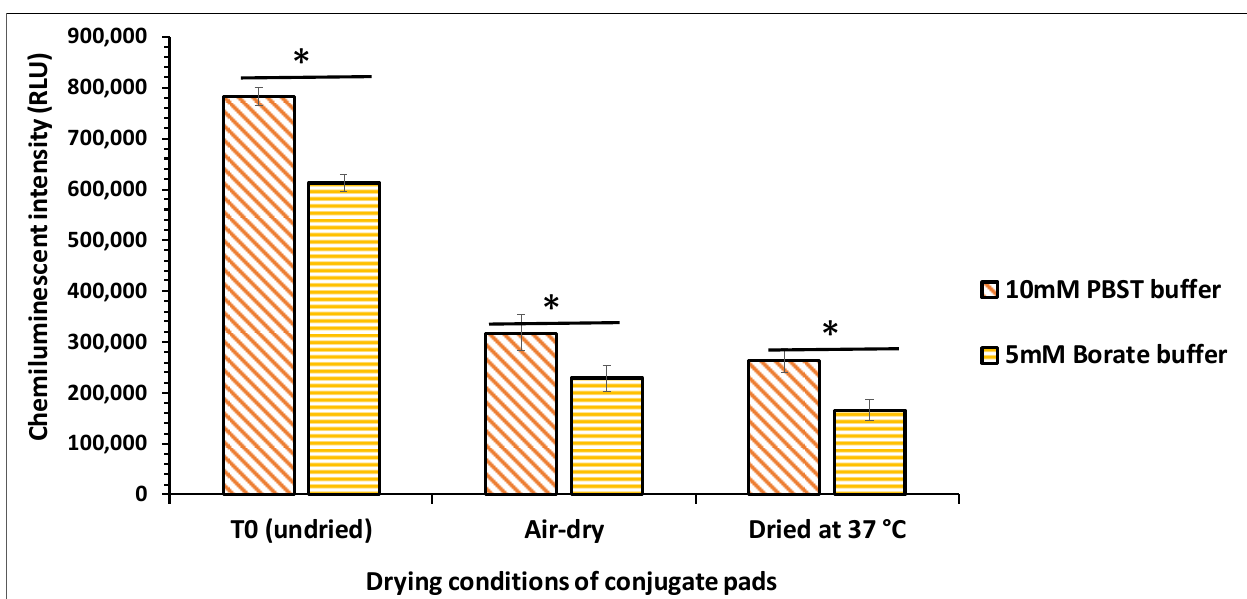
Figure 2. Effect of 5 mM borate and 10 mM PBST buffer on the stability of conjugate pads during the drying process (* p < 0.05 by ANOVA).